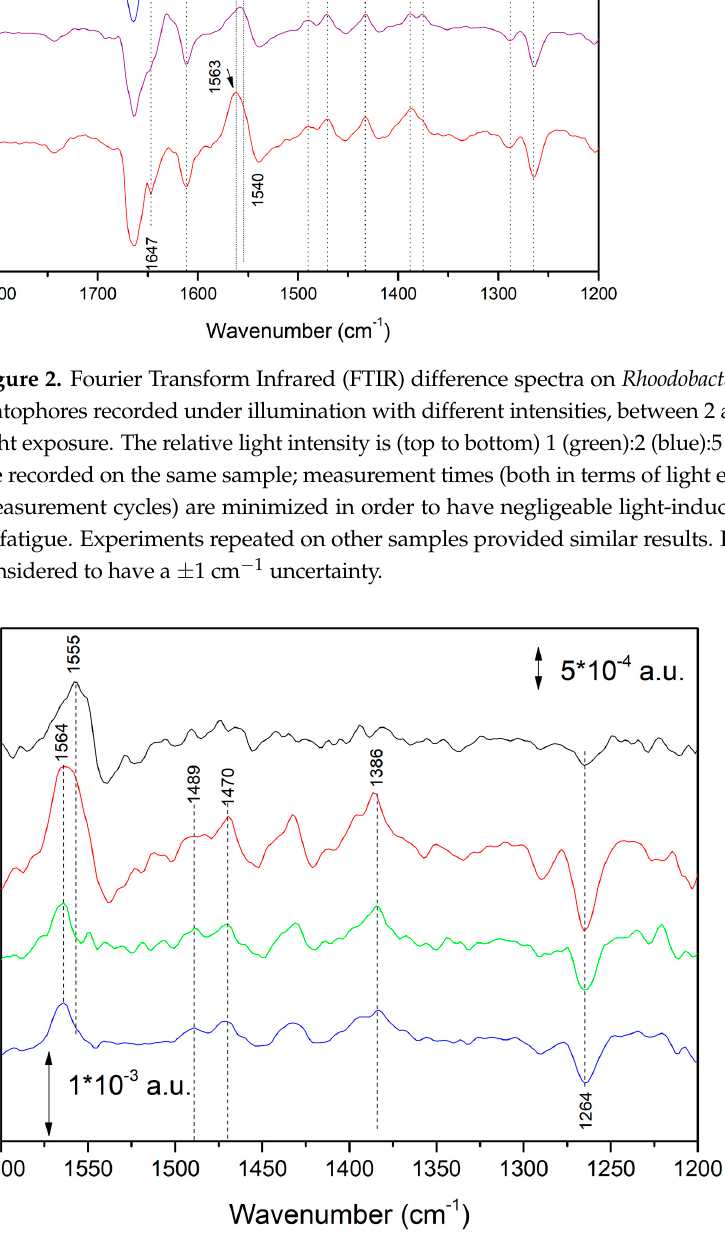
Figure 3. Time evolution of the FTIR difference spectra of Rb. sphaeroides chromatophores after onset of continuous illumination at higher illumination intensity (upper two traces) and after switching off the illumination (two traces at the bottom). Black trace (first from top): recorded between 0 and 434 ms after light onset. Red trace (second from top): recorded between 3878 and 4312 ms after light onset. Green trace (third from top): recorded between 434 and 868 ms after switching off the light. Blue trace (fourth from top) recorded between 1300 and 3000 ms after switching off the light. Peak position should be considered to have a ±1 cm − 1 uncertainty.